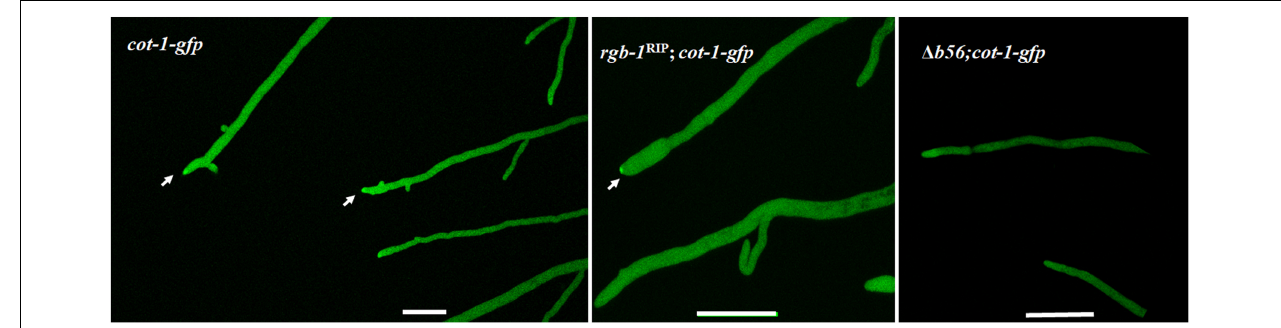
FIGURE 6 | Localization pattern of COT1::GFP in rgb-1 RIP and (cid:49) b56 backgrounds as determine by confocal microscopy. High abundance of COT1::GFP is evident in wt and I rgb-1 RIP (marked by arrows), but not (cid:49) b56 backgrounds. Bars indicate 10 µ m.